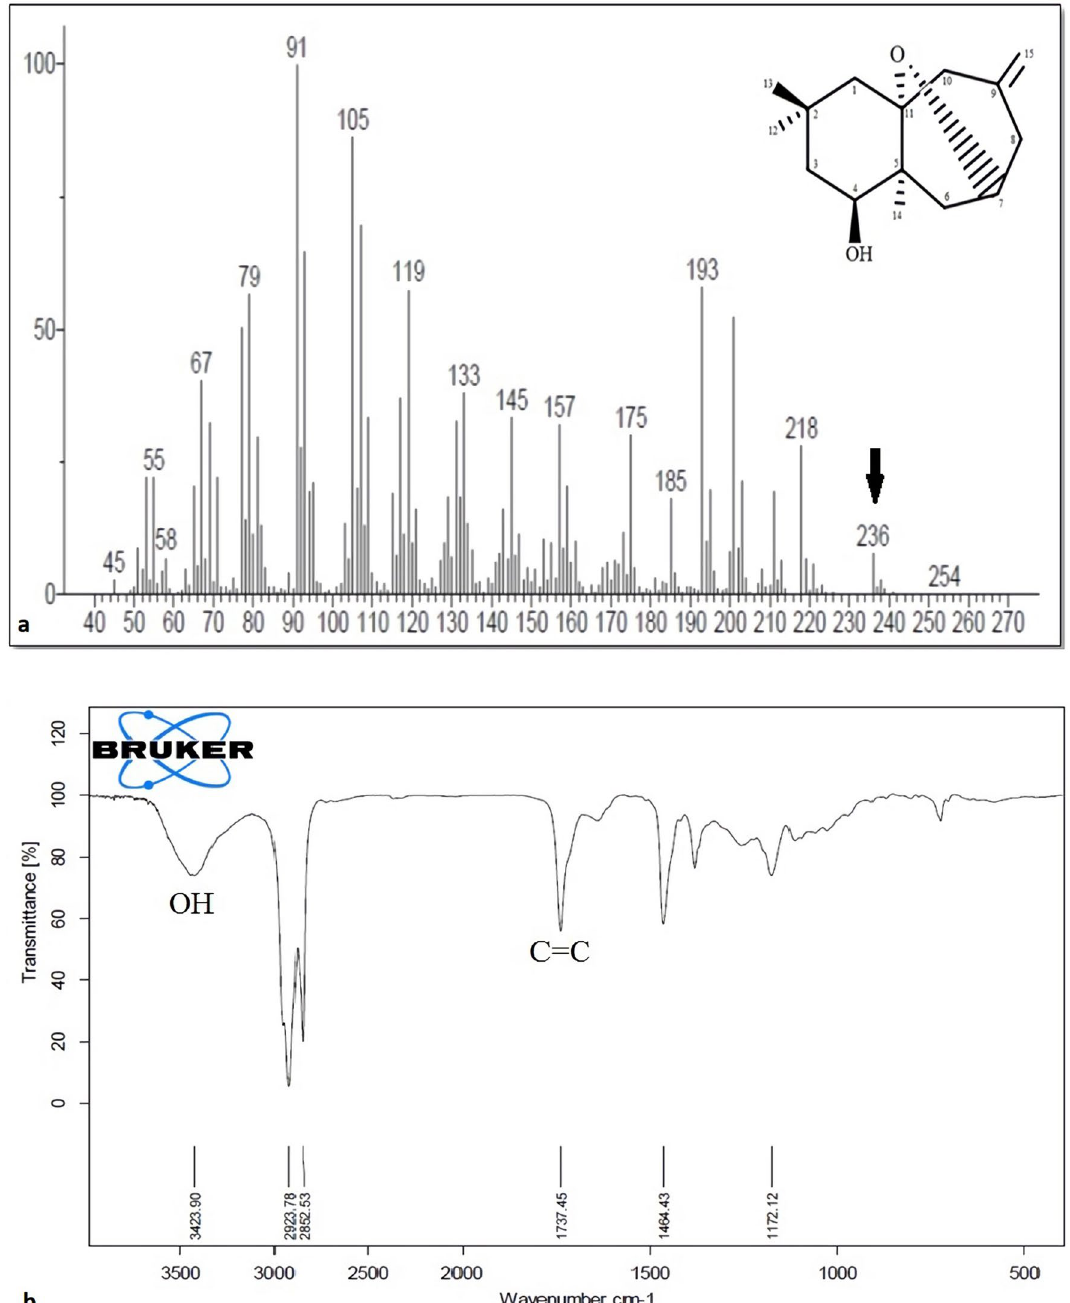
Figure 4. The ( a ) GC/MS and ( b ) FT-IR spectra of compound 2